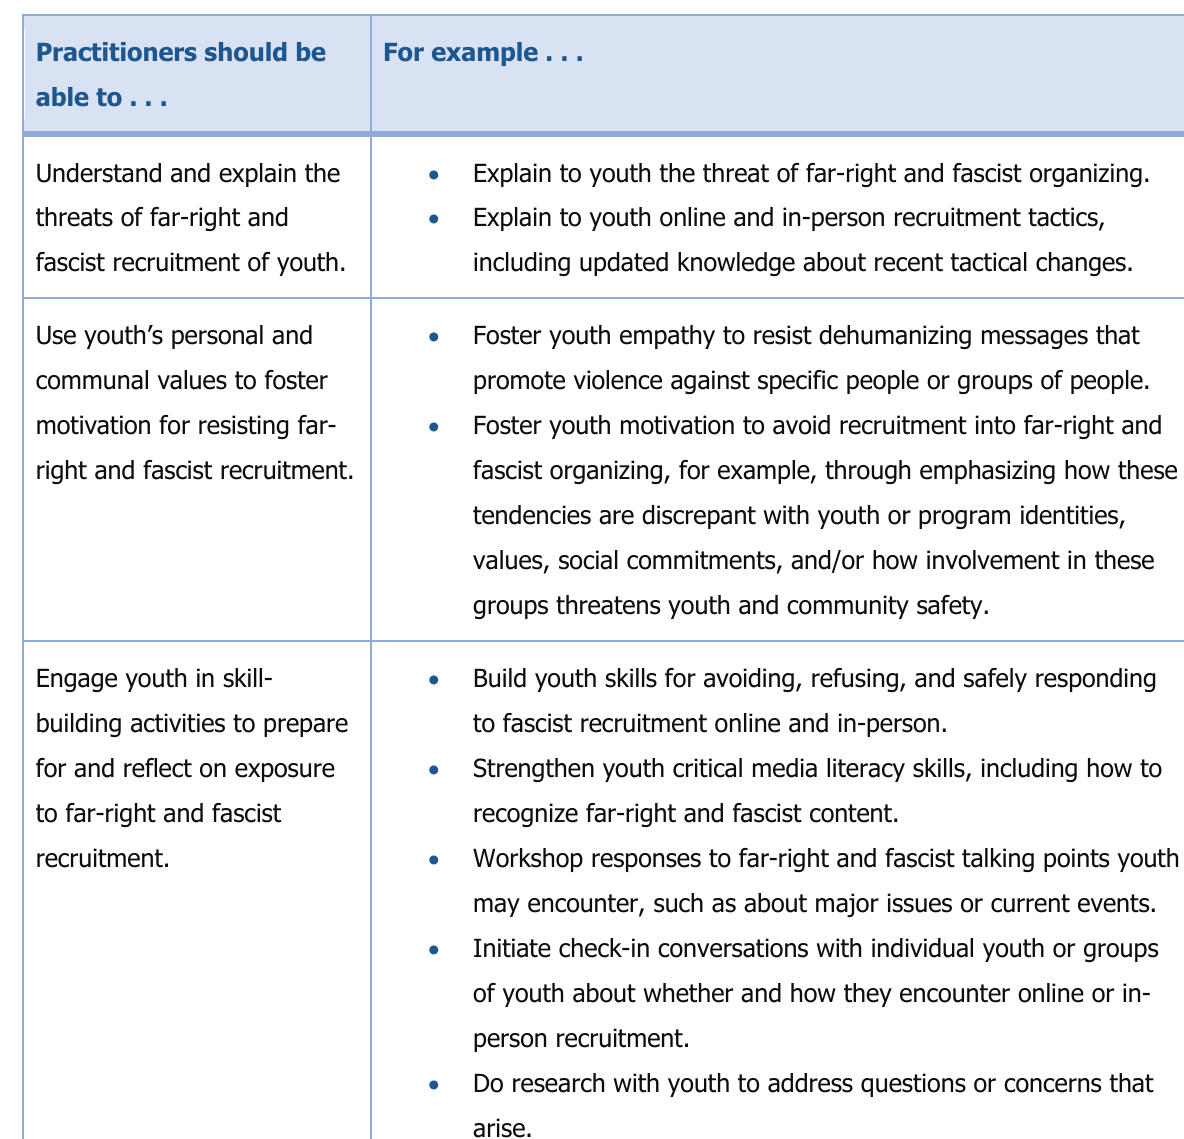
Table 1. Immunization Strategies and